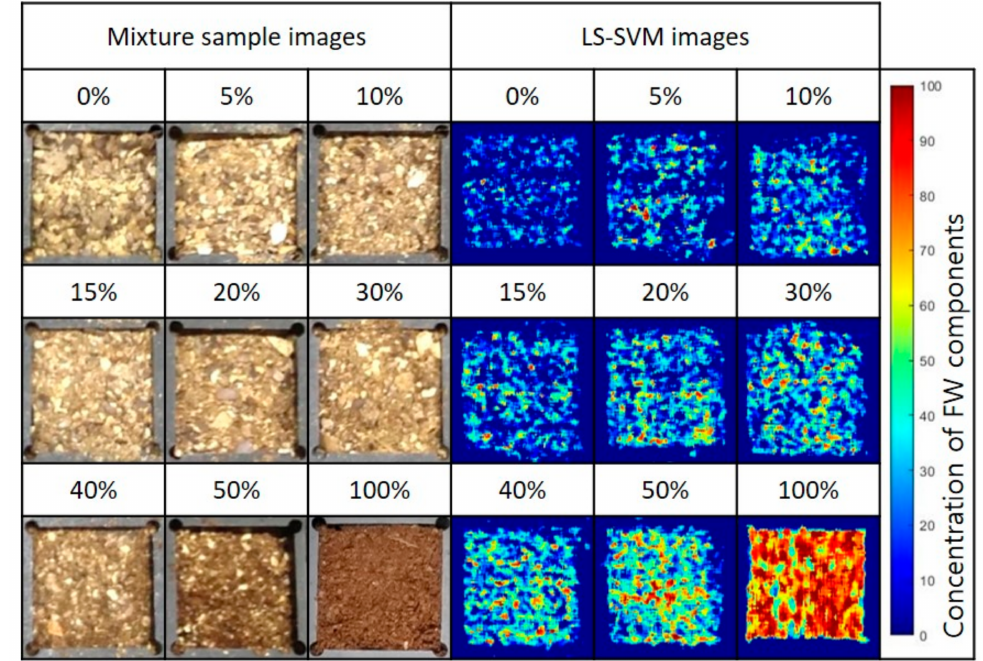
Figure 7. FWC visualization in mixture samples and images produced by LS-SVM